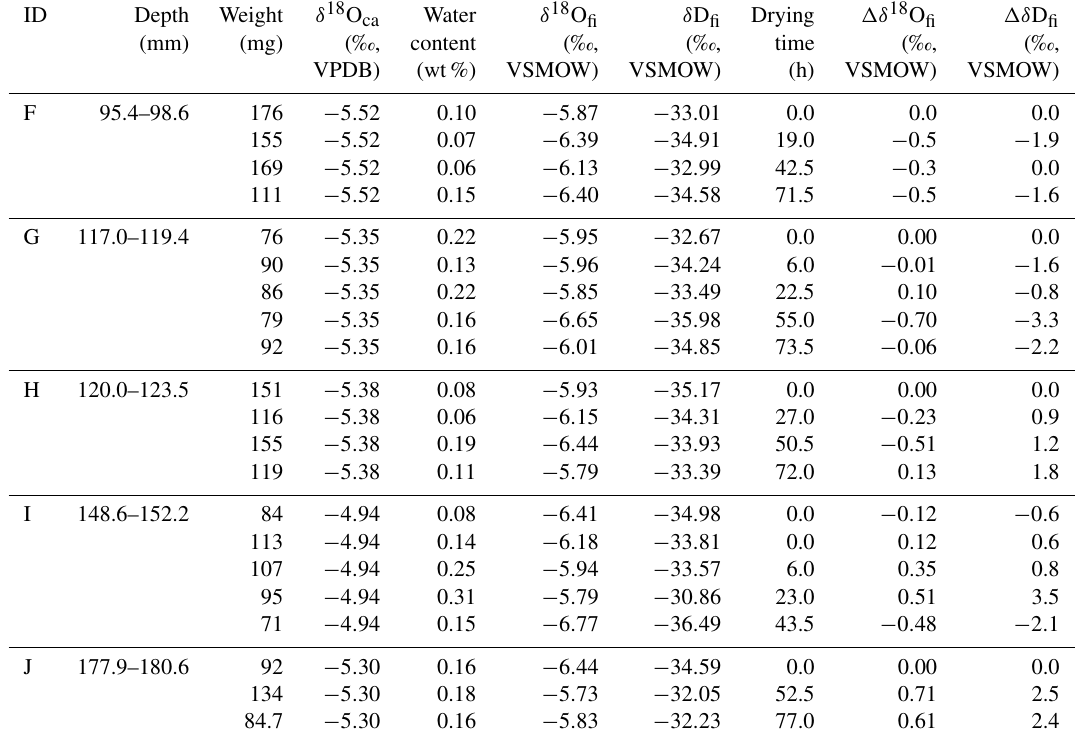
Table 2. Isotopic compositions of inclusion waters and calcite in the HSN1 stalagmite for the 25 ◦ C